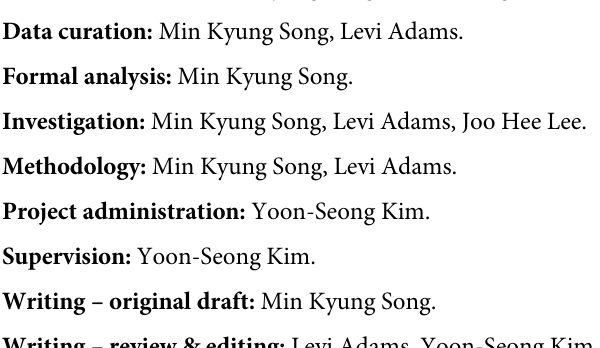
S1 Fig. Assessing dopaminergic neurons in the SN 1 weeks after delivery of AAV-WT- α - Syn. Representative micrographs of TH immunostaining in the SN. (TIF) S2 Fig. Comparison of TH-positive neurons between the contralateral and ipsilateral sides in the SN at 9 weeks after delivery of GFP-only AAV. (A) Representative micrographs of TH immunostaining in the SN. (B) % of TH-positive neurons in the SN compared to the contralat- eral side. Data are presented as the mean ± S.E.M. (Student t-test, n = 6 mice).